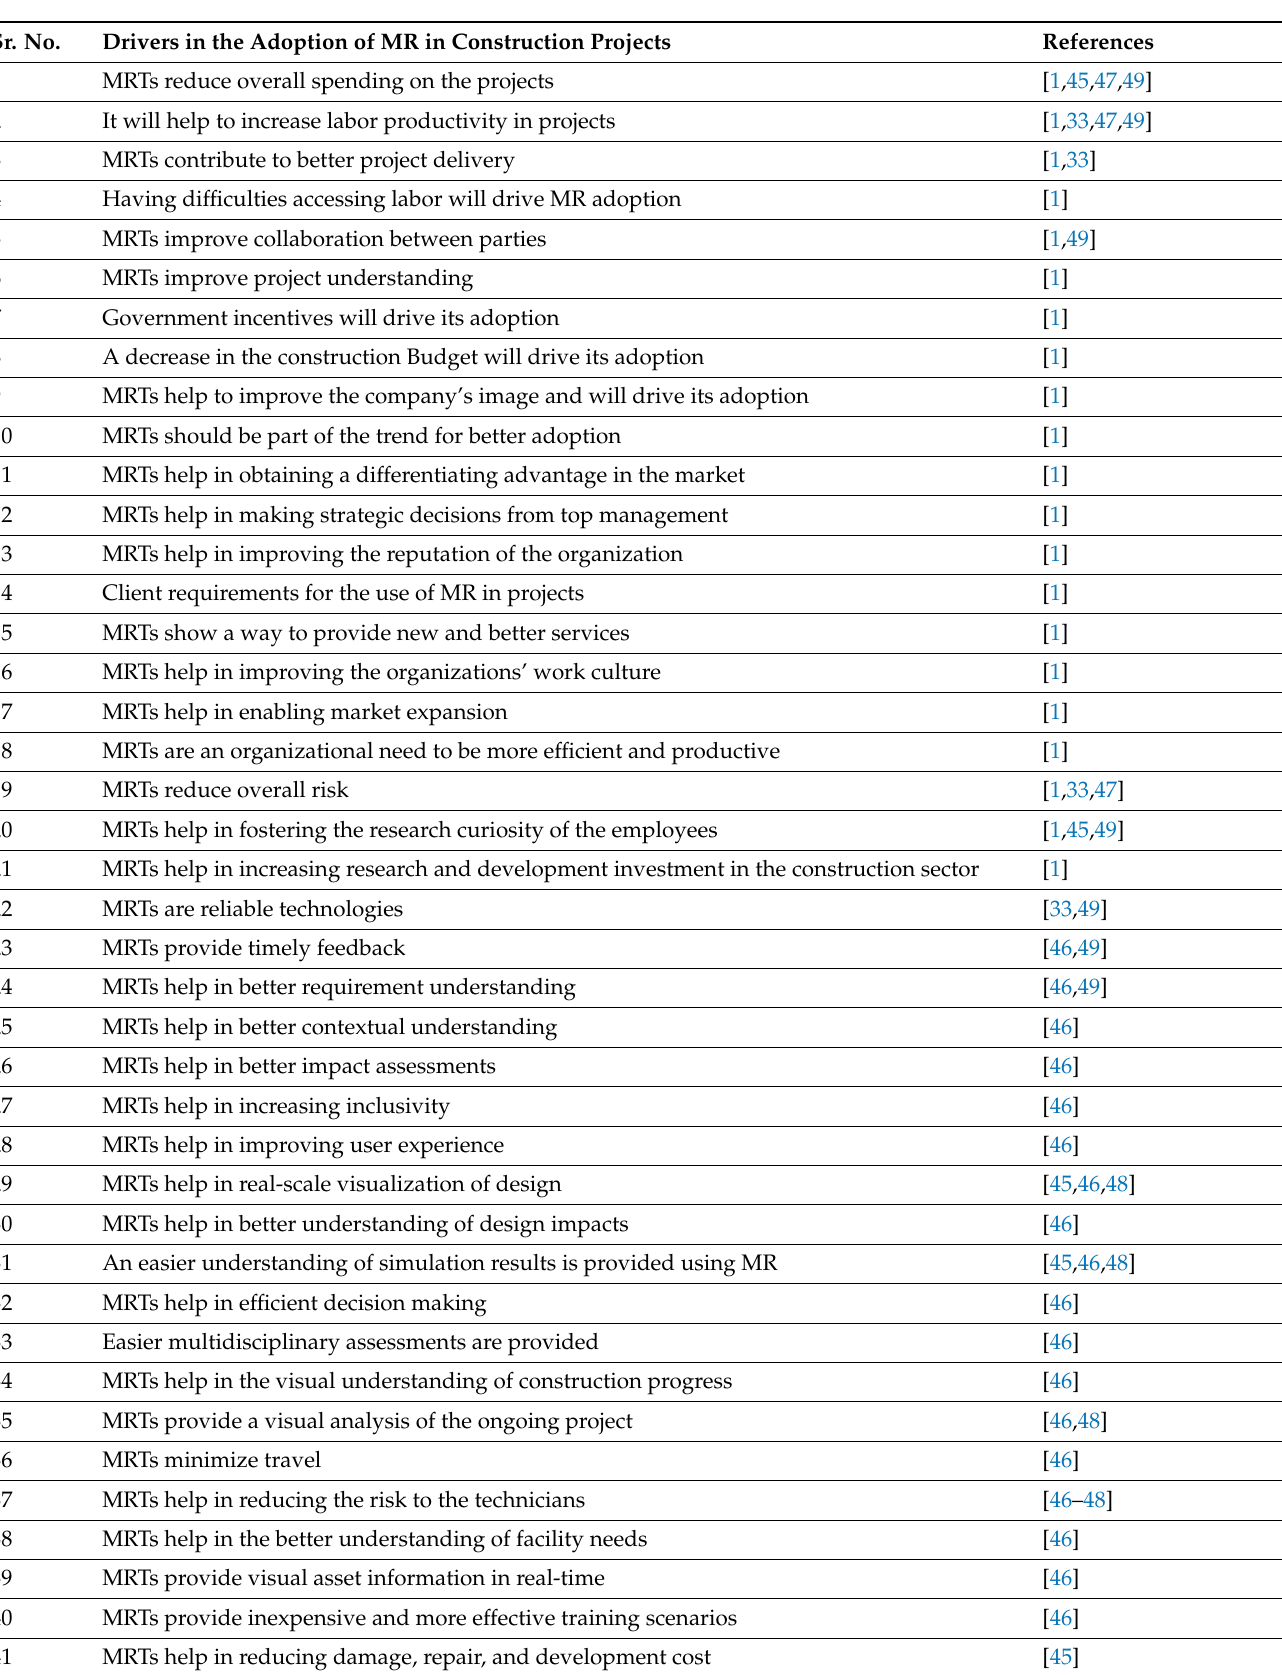
Table 2. Drivers of MR